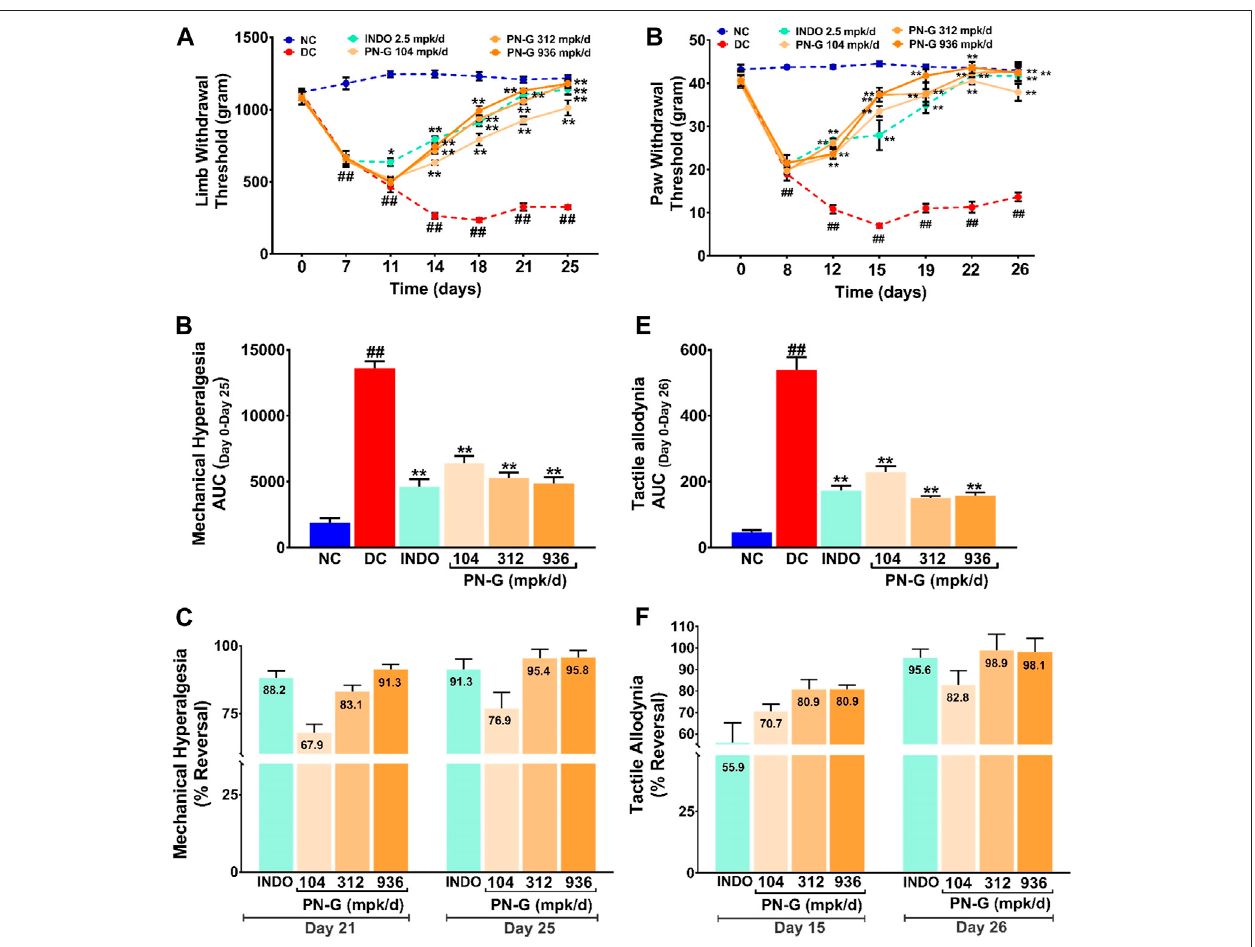
FIGURE 5 | PN-G exhibits dose-dependent reversal of MIA-induced mechanical hyperalgesia and tactile allodynia. (A,D) Line graphs showing the effects of PN-G treatments on MIA-induced mechanical hyperalgesia (A) and tactile allodynia (D) spanning over the entire experimental regime of 26 days. Data was analyzed through two-way ANOVA followed by Tukey ’ s multiple comparison. ## indicates signi fi cant difference with respect to NC ( p < 0.01) whereas * and ** depict a statistically signi fi canteffectwhencomparedtoDC(* p < 0.05and** p < 0.01). (B,E) QuantitativerepresentationsoftheeffectsofPN-Gtreatmentsonmechanicalhyperalgesia (B) andtactileallodynia (E) asareaunderthecurves(AUCs)calculatedfromdatashownin (A) and (D) .Thedatawasstatisticallyanalyzedbyemployingone-wayANOVA followed byDunnett ’ smultiple comparison test. ## designates signi fi cantdifference withrespect toNC ( p < 0.01) whereas** depicts astatistically signi fi canteffect when comparedtoDC( p < 0.01). (C,F) Bargraphsshowingthecomparisonsbetweentheinhibitoryeffects,seenonmechanicalhyperalgesia (C) andtactileallodynia (F) ,due toindomethacin (INDO)and PN-Gtreatments.Valueswithinthebarsrepresent percentage reversal. Alldatawasrepresented asmean±SEM( n =6animalsper